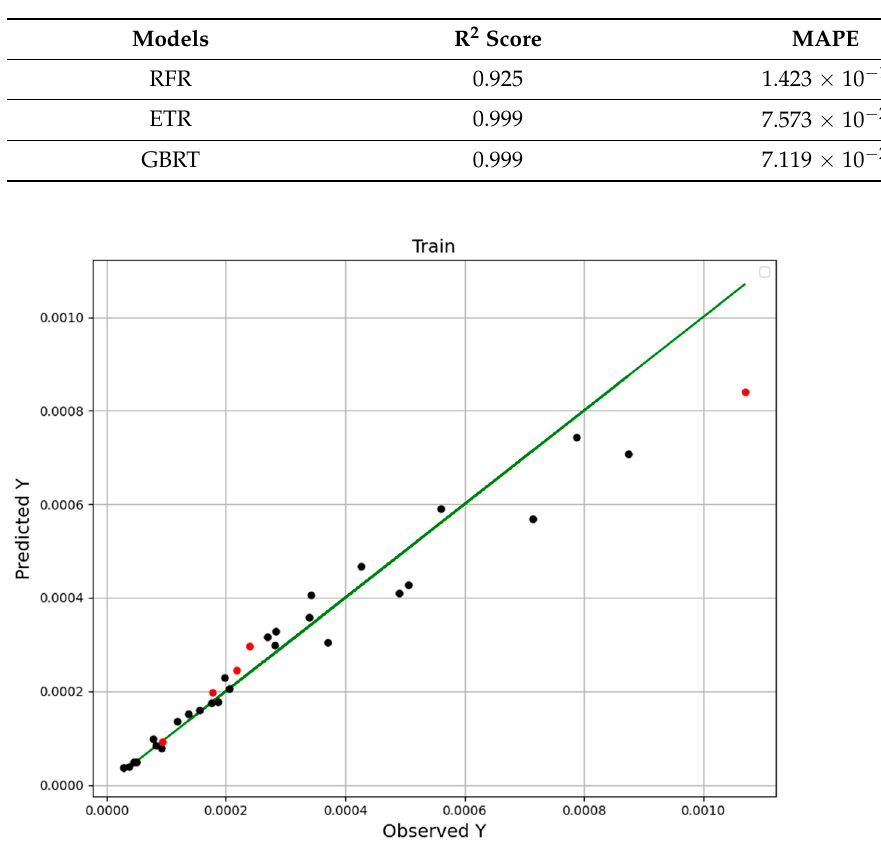
Figure 2. RFR Model: test and train data predictions .